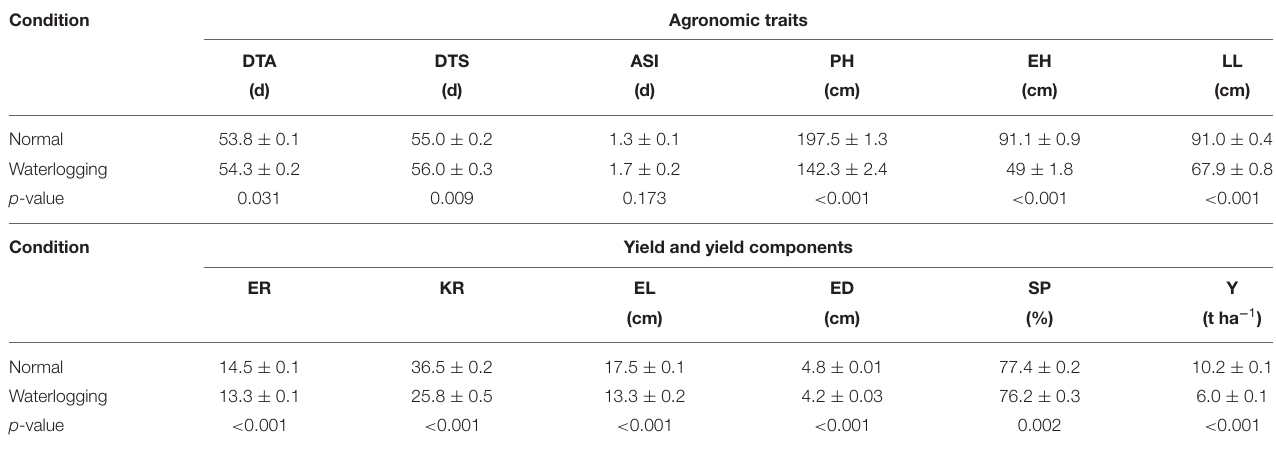
TABLE 3 | Means of agronomic and yield traits in maize under normal and waterlogging conditions.